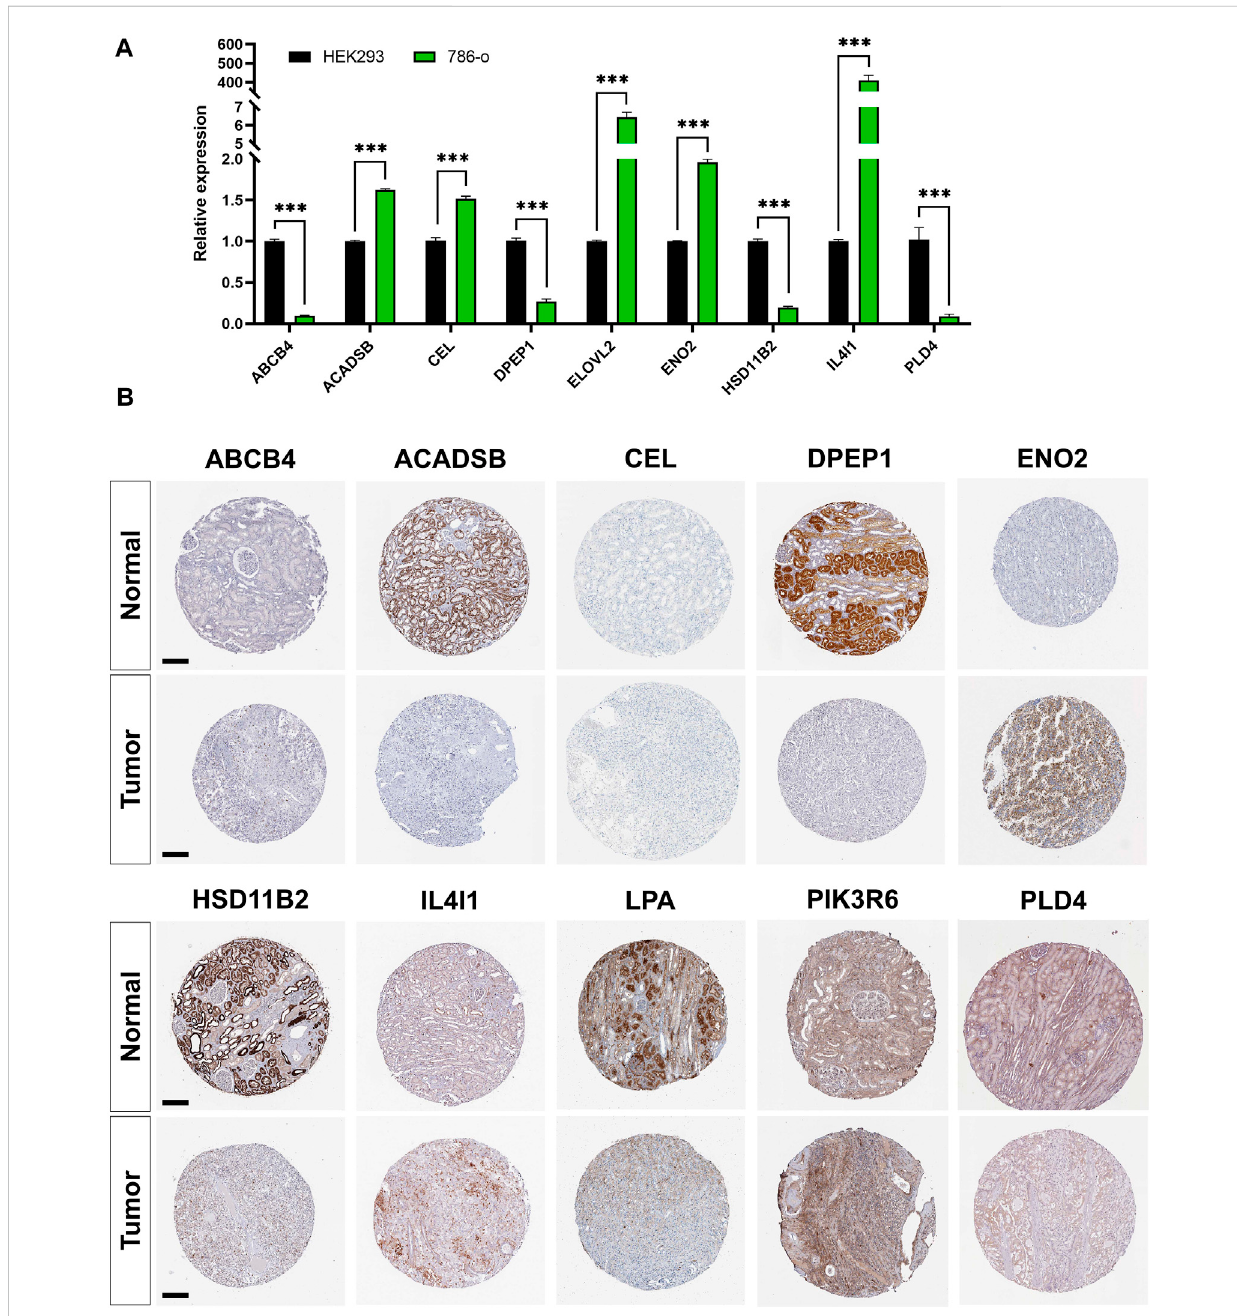
FIGURE 8 Validation of mRNA and protein expressions of prognostic lipid metabolism genes (LMGs). (A) The expression level of ABCB4 , DPEP1 , IL4I1 , ENO2 , PLD4 , CEL , HSD11B2 , ACADSB ,and ELOVL2